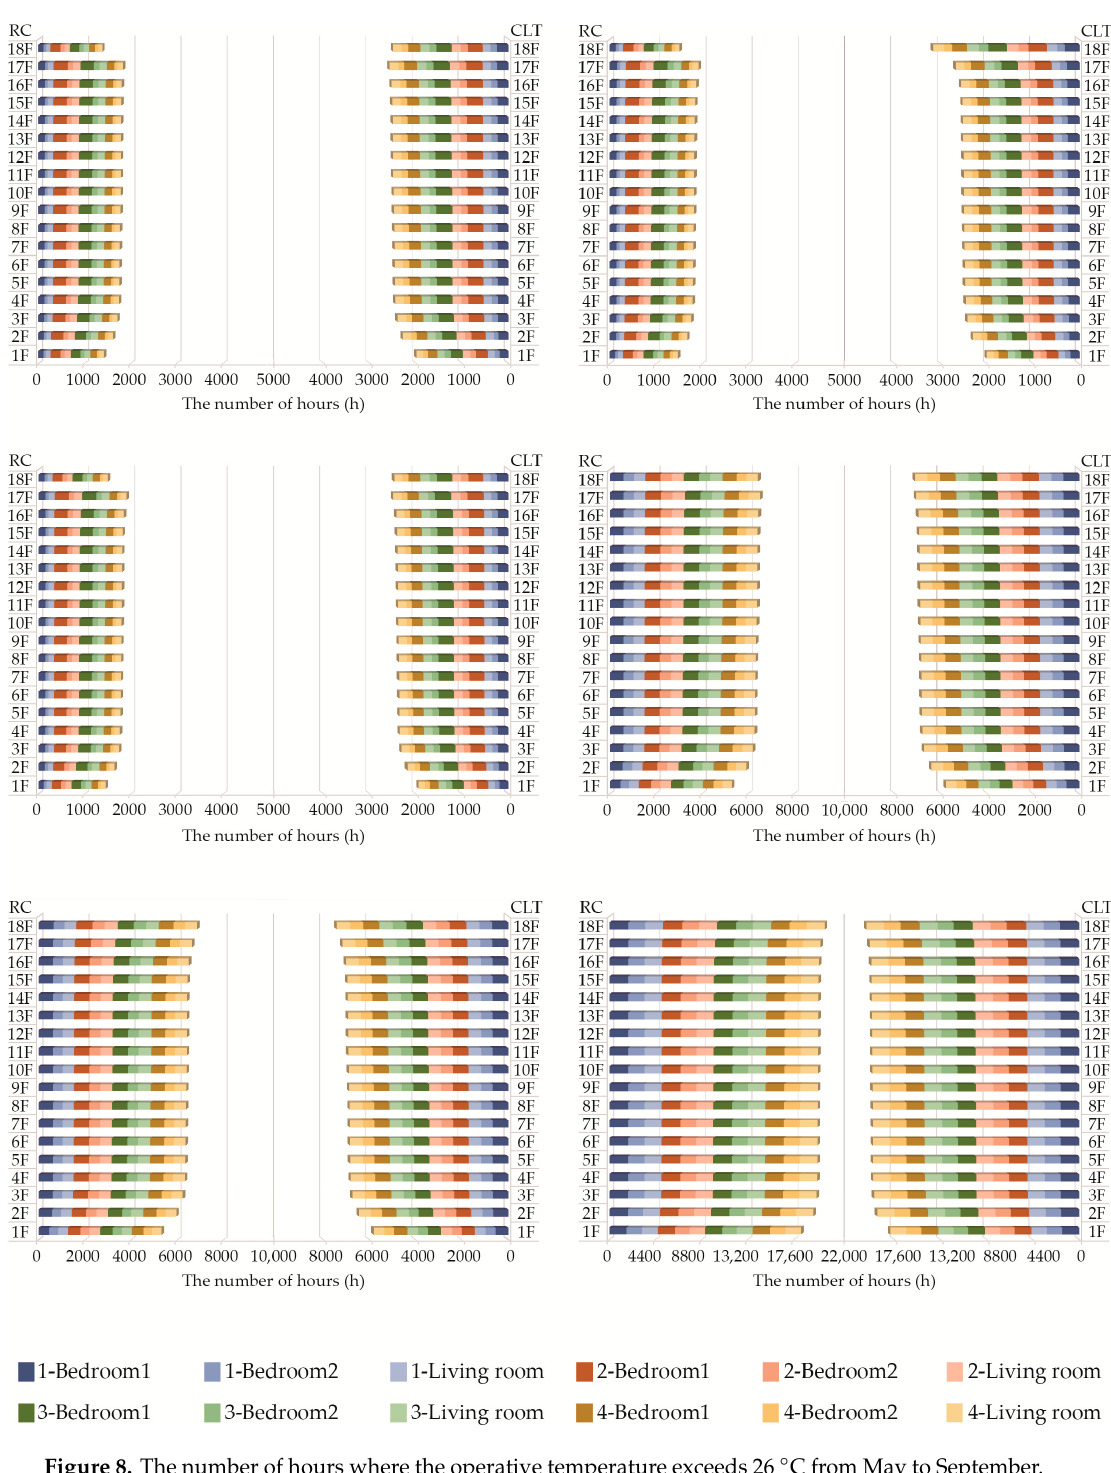
Figure 8. The number of hours where the operative temperature exceeds 26 ◦ C from May to